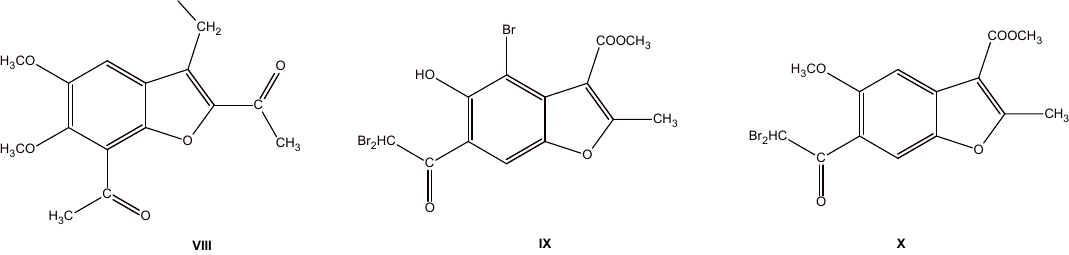
Figure 4. Structures of the benzofuran derivatives VIII – X , lead compounds used in the present